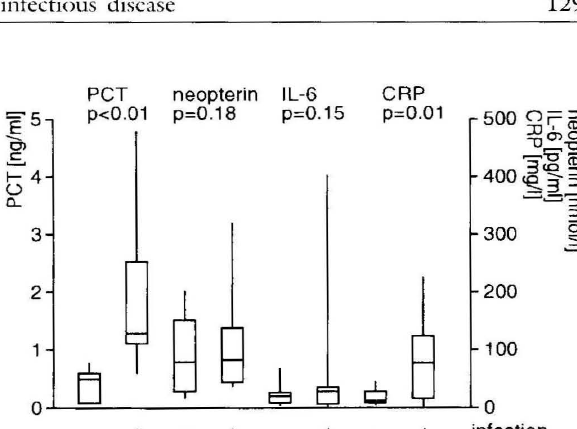
figurc 3. Procalcitonin (PC'T) , neopterin, interleukin-6 (IL- 6) and C-reactive protein (CRP) values during the 16 cpisodes of systemic bacterial infection (occurring in 11 patients) compared with the valucs obtained during an infection-free interval 4-6 weeks before or after treatment. The data are depicted as box-plot diagrams, with the box encompassing the range of values from the 25% percentile (lower bar) to the 75% percentile (upper bar). The horizontal line within the box represents the median, and the vertical lines above and below the box signify the maximum and minimum values. P values were determined by Wilcoxon signed rank test. [reproduced from Eberhard OK, et al. (52), with permission from The American College of Rheumatology